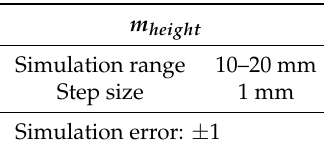
Table 5. Parameter m height simulation